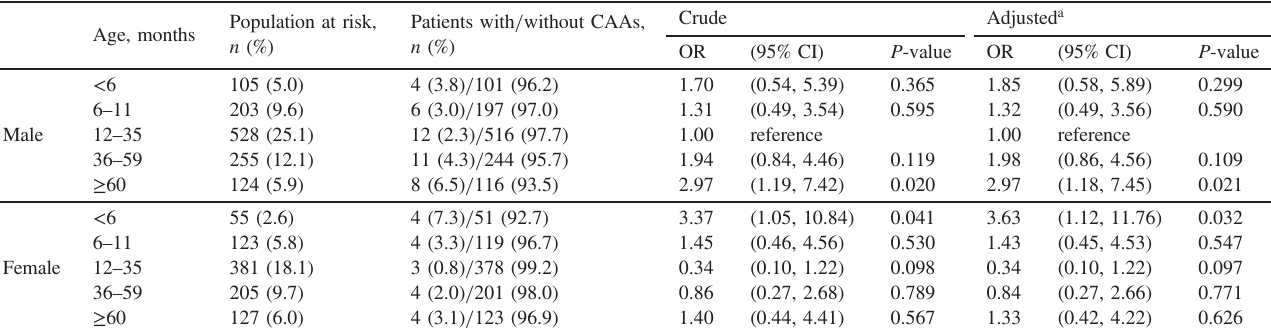
CI, con fi dence interval; OR, odds ratio. a Adjusted for climate season (four categories) of onset and administration of intravenous immunoglobulin